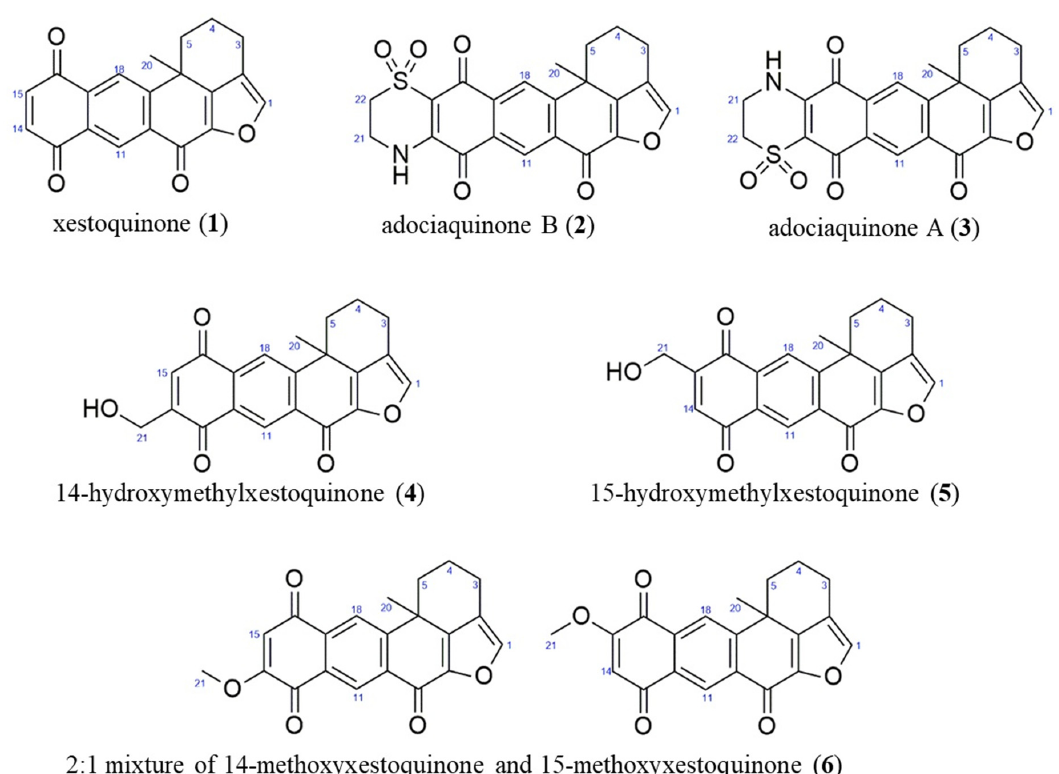
Figure 2. Anti-inflammatory compounds from the marine sponge Neopetrosia compacta .